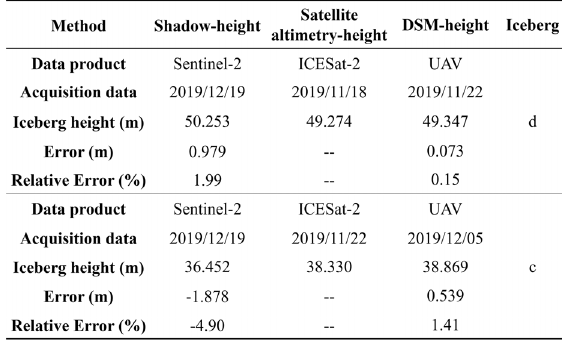
Table 2 . Details of experiment data and results comparisons. The icebergs “d” and “c” correspond to the icebergs in Figure